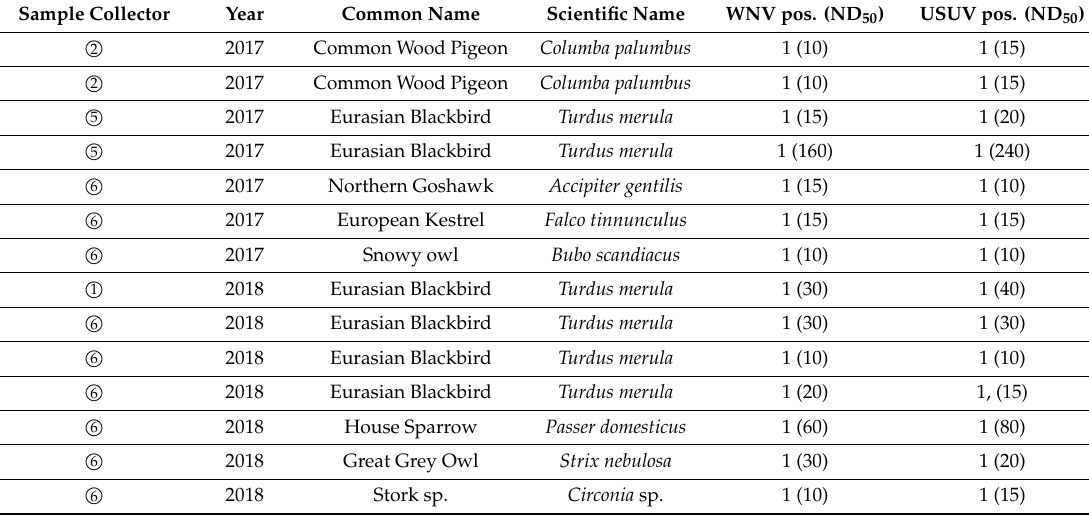
Table 7. No di ff erentiation between WNV and USUV by neutralization assay